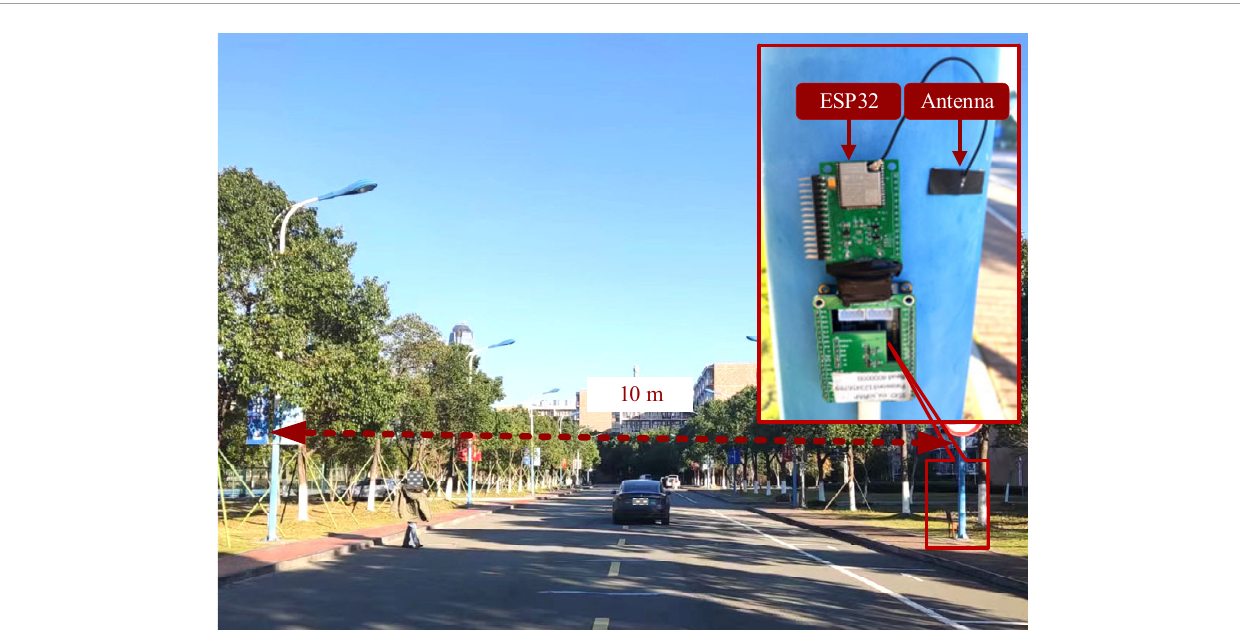
FIGURE7 Experimental scenarios and WTP installation